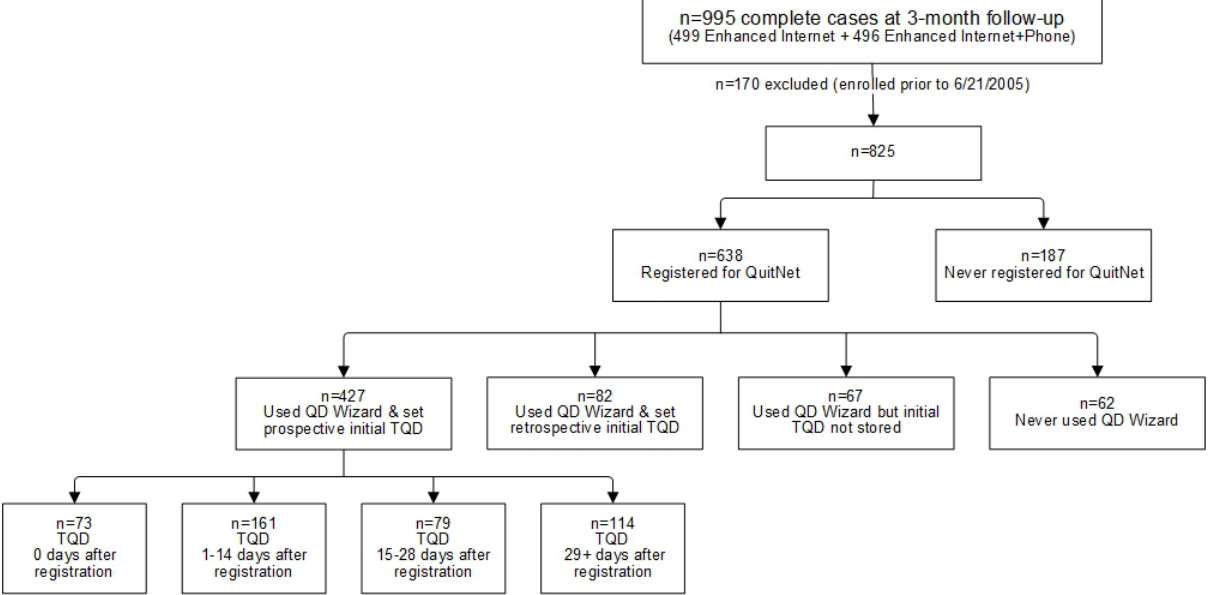
Figure 1. Diagram of data flow from complete cases randomized to the enhanced Internet and enhanced Internet plus telephone counseling arms based on QuitNet registration status, Quit Date (QD) Wizard use, and initial target quit date (TQD) status, and latency to TQD relative to registration date (among prospective quit date